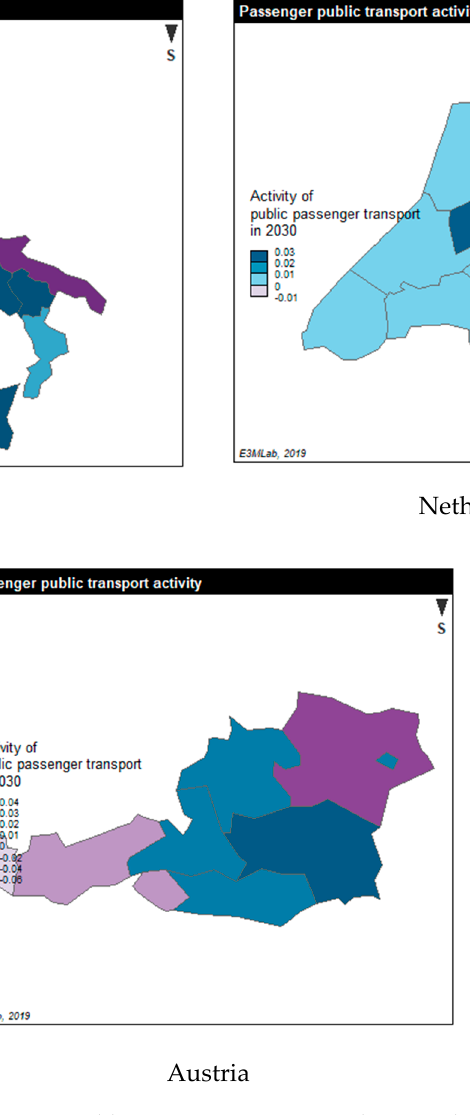
Figure 5. Percentage change in public passenger transport relative to the base case in 2030.